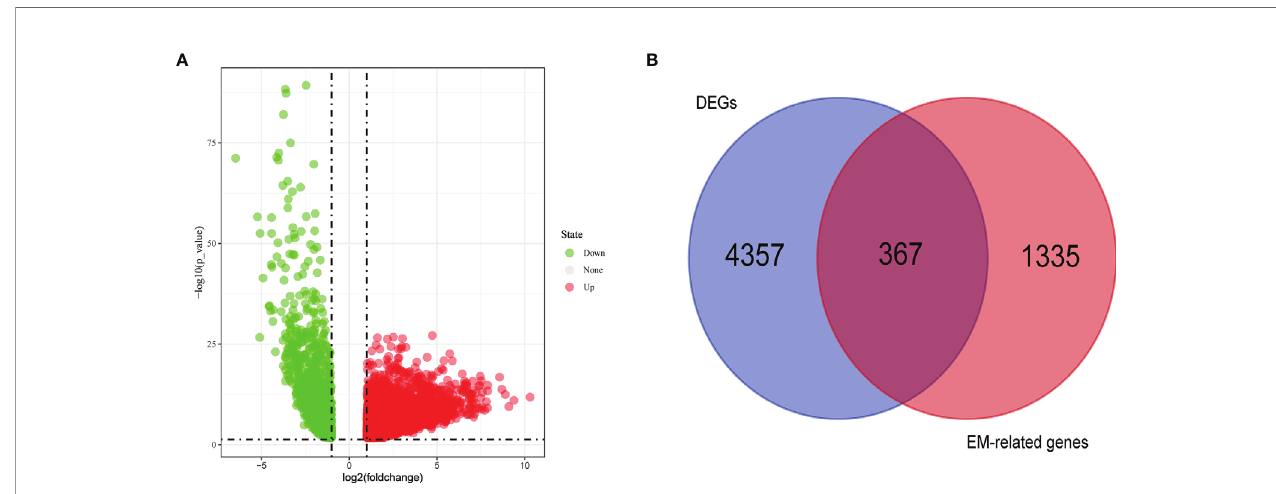
FIGURE 1 | Volcano plot of differentially expressed genes (DEGs) in TCGA cohort (A) and Venn chart showed the number of DEGs associated with energy metabolism related genes (B)